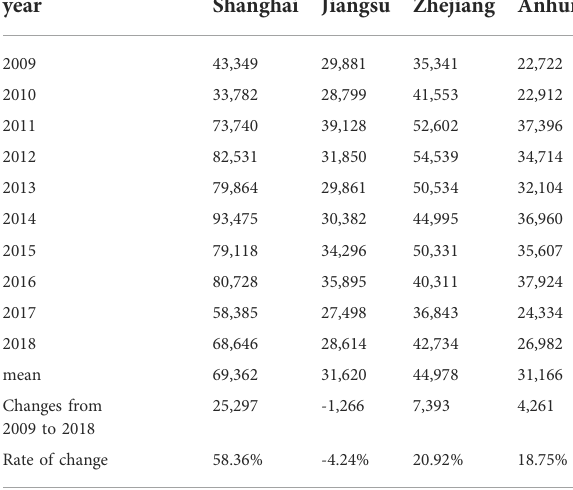
TABLE 6 The per unit area water ESV in the Yangtze river delta region (yuan/ha).